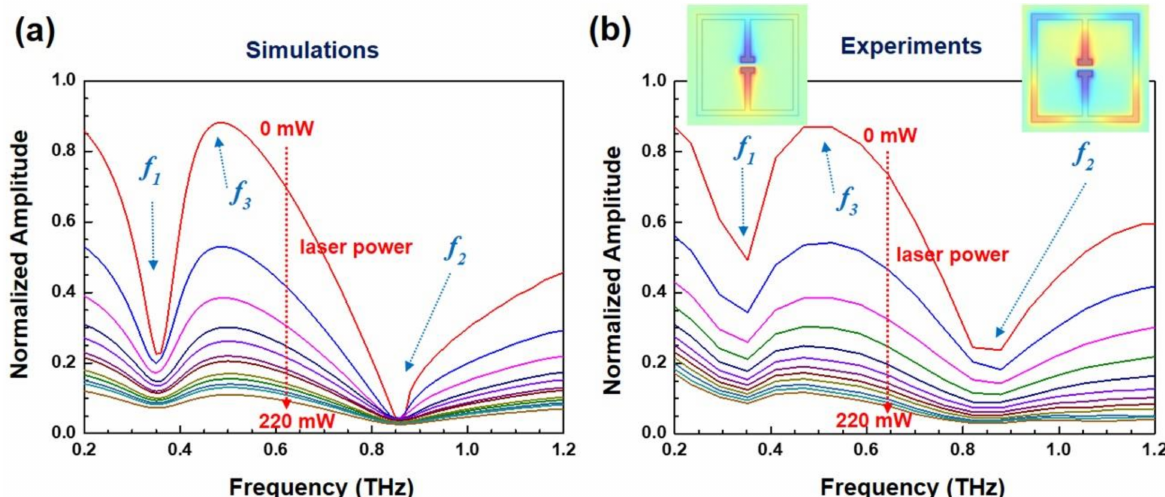
Figure 2. ( a ) Simulation results of the transmission amplitude for the tri-layer sample. ( b ) Normalized THz-transmission spectra measured through the tri-layer sample with different laser powers of the optical beam for photoexcitation in the range from 0 mW to 220 mW (3.1 W/cm 2 ) with a step of 20 mW (0.28 W/cm 2 ). The insets show electric field distributions of the fundamental ( f 1 ) and second-order LC ( f 2 ) resonances at frequencies of 0.35 THz and 0.85 THz,